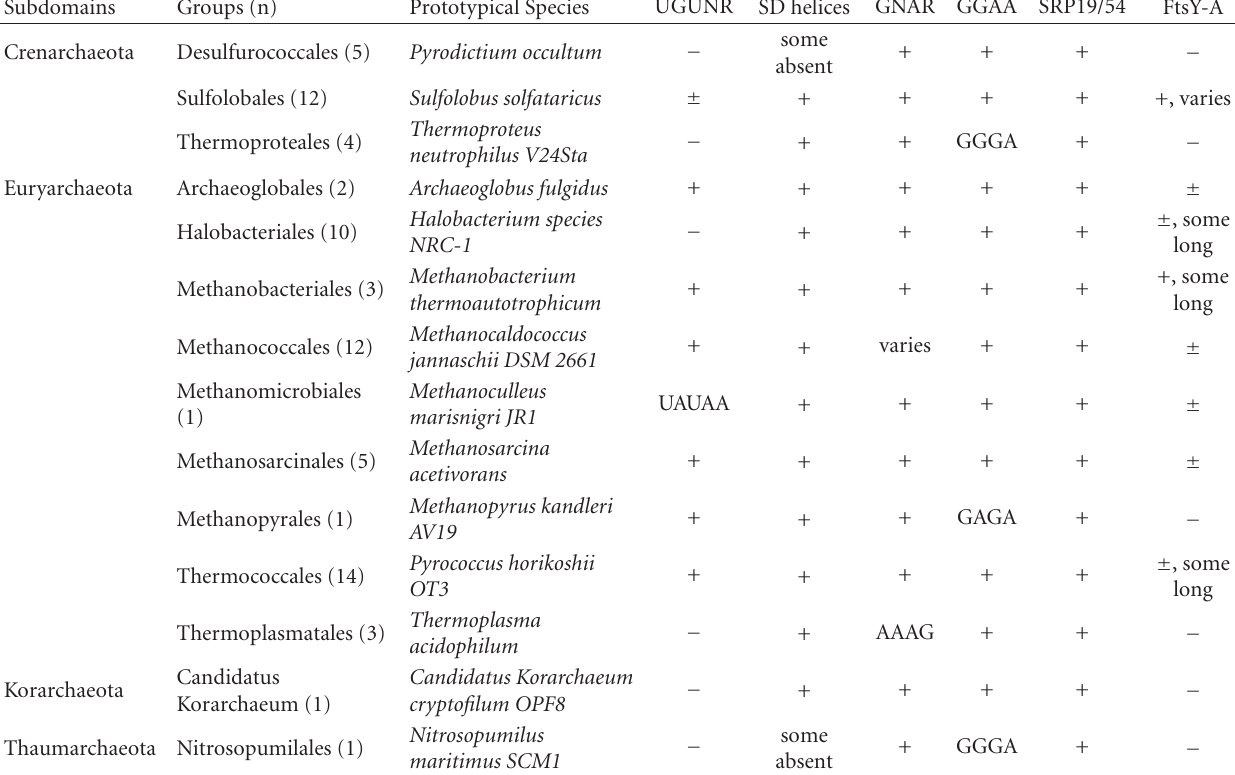
Table 2: Taxonomic distribution of archaea SRP features. Indicated are the archaea subdomains, the number of species identified in each group, and a representative species. Features are the UGUNR motif (N is any nucleotide and R is a purine residue), helices (typically 1 to 4) in the small SRP domain (SD), the GNAR tetranucleotide loop (tetraloop) of helix 6, the GGAA tetraloop of helix 8, proteins SRP19 and SRP54 (SRP19/54), and the acidic (A) domain of the FtsY receptor (FtsY-A). “+” shows presence, “ − ” absence, and “ ± ” indicates that this feature is present only in a subset of the group members. Sequences deviating from the top-listed motif (e.g., the GGGA in the Thermoproteales) are given. The structural alignments of the 81 identified archaea SRP RNAs and the protein alignments of SRP19, SRP54 and FtsY are provided online as listed in Supplementary Materials 2 available online at doi:10.1155/2010/485051 and are available at http://rnp.uthct.edu/rnp/SRPDB/srprna.html. Features of the SRP RNA in all three domains of life have been recently described in detail in [1].